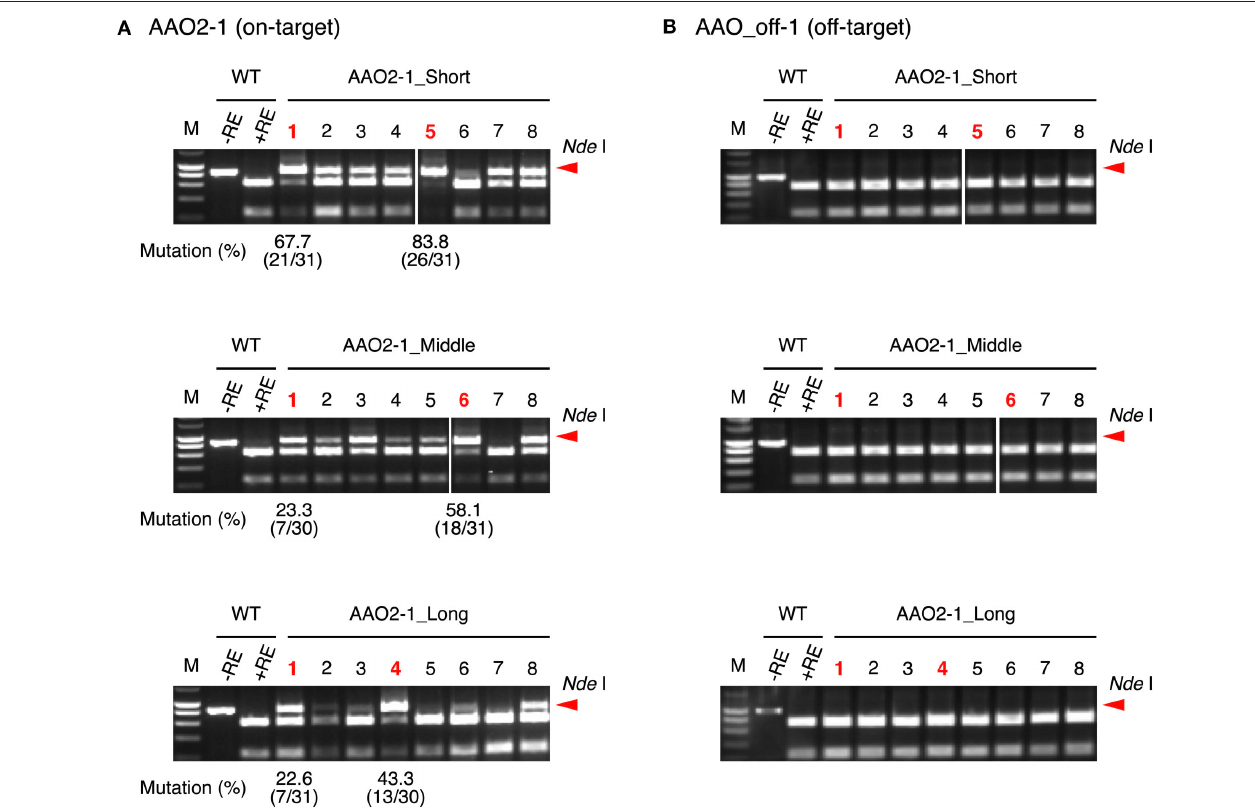
FIGURE 4 | Off-target mutation analysis using CAPS assay at (A) AAO2-1 on-target site and (B) AAO_off-1 off-target candidate site using crRNA with guide sequences of different lengths. Mutation frequencies of selected calli (shown in red) were calculated from the ratio of sequenced clones with mutation. M, DNA molecular weight; –RE, without restriction enzyme; + RE, with restriction enzyme. Red arrowheads indicate the position of undigested PCR fragments. CAPS images of AAO2-1_Short and AAO2-1_Middle guides in AAO2-1 target site (A: upper and middle sides) and AAO2-1_Short and AAO2-1_Middle guides in AAO_off-1 target site (B: upper and middle sides) were grouping images from different parts of the same agarose gel electrophoresis image, respectively.